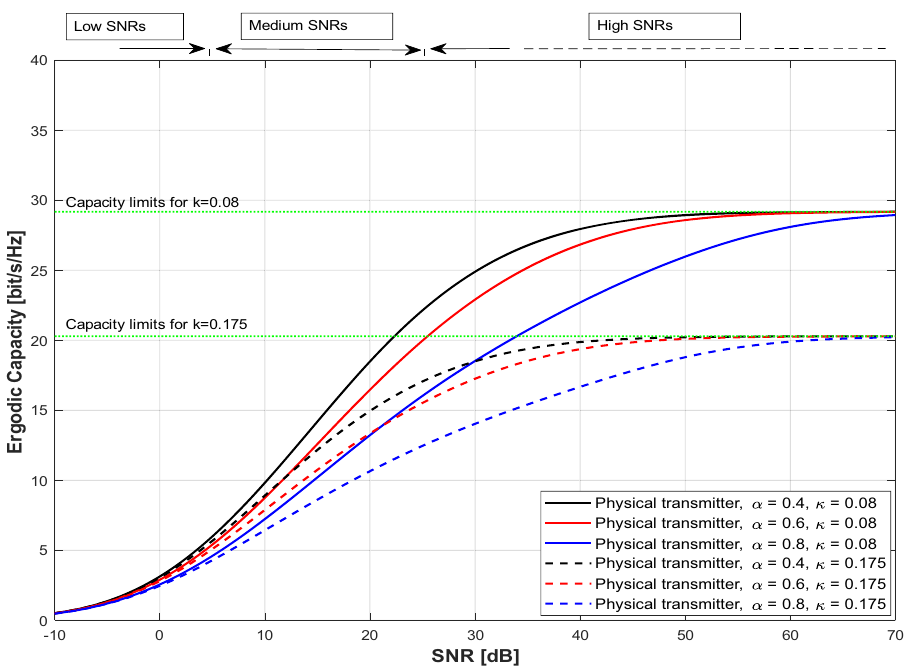
Figure 3: The e ff ect of increasing the correlation coe ffi cient on the 4 4 × MIMO channel capacity in the case of the physical transmitter with di ff erent impairment levels κ 0.08, 0.175 {